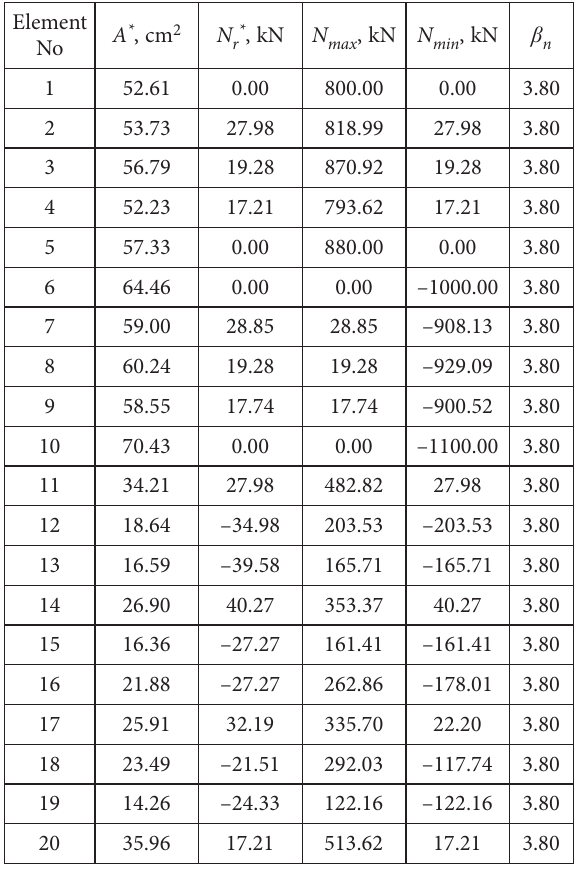
Table 1. Results of the problem